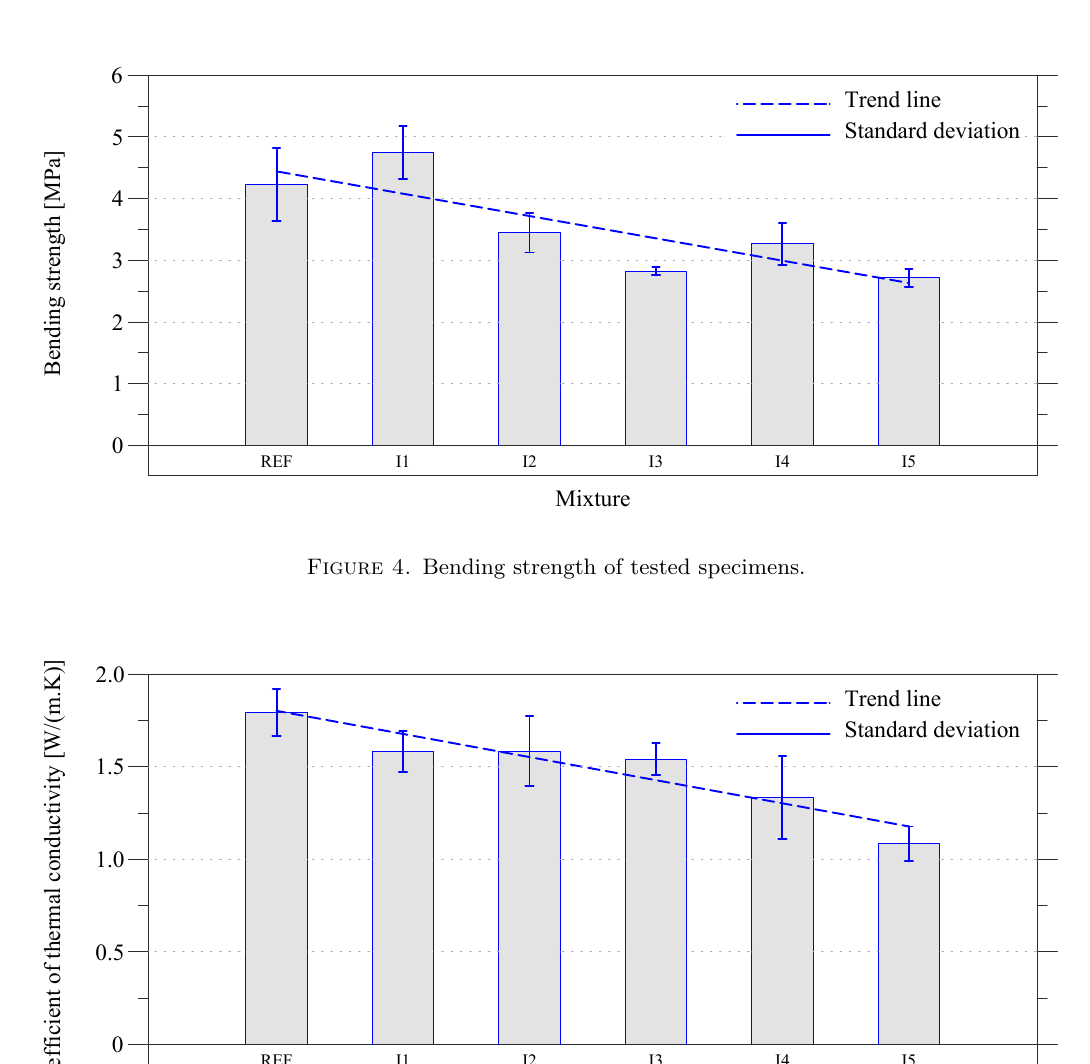
Figure 3. Compressive strength of tested specimens.